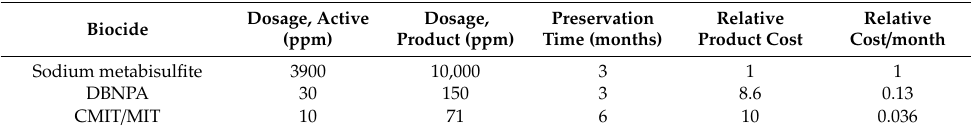
Table 11. Comparison of preservative solutions, DBNPA and CMIT / MIT (isothiazolone), with